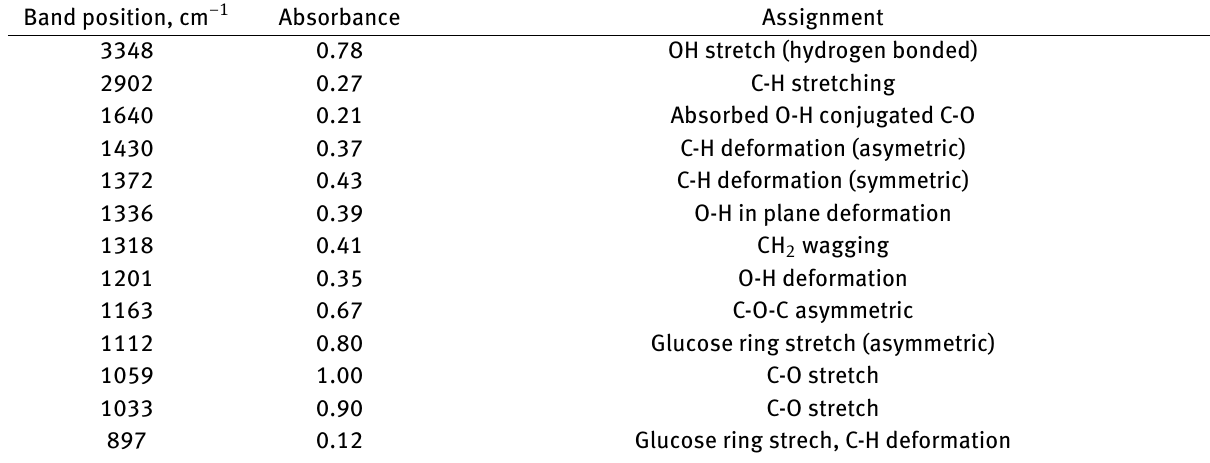
Table 8: FTIR absorption bands and identifications for lignin reference [32] Band position, cm